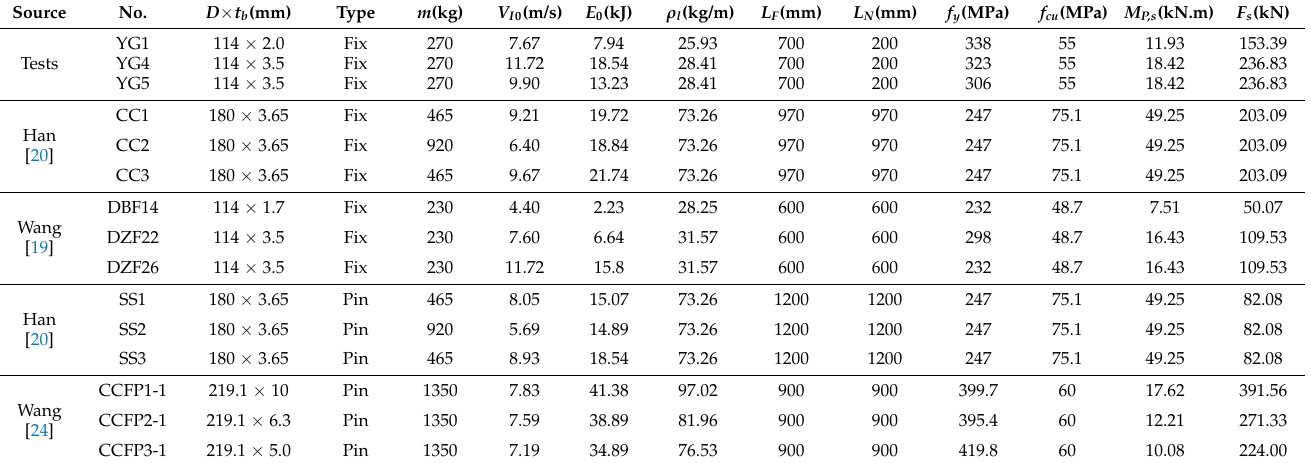
Table 1. Design Table 1. Design parameters.